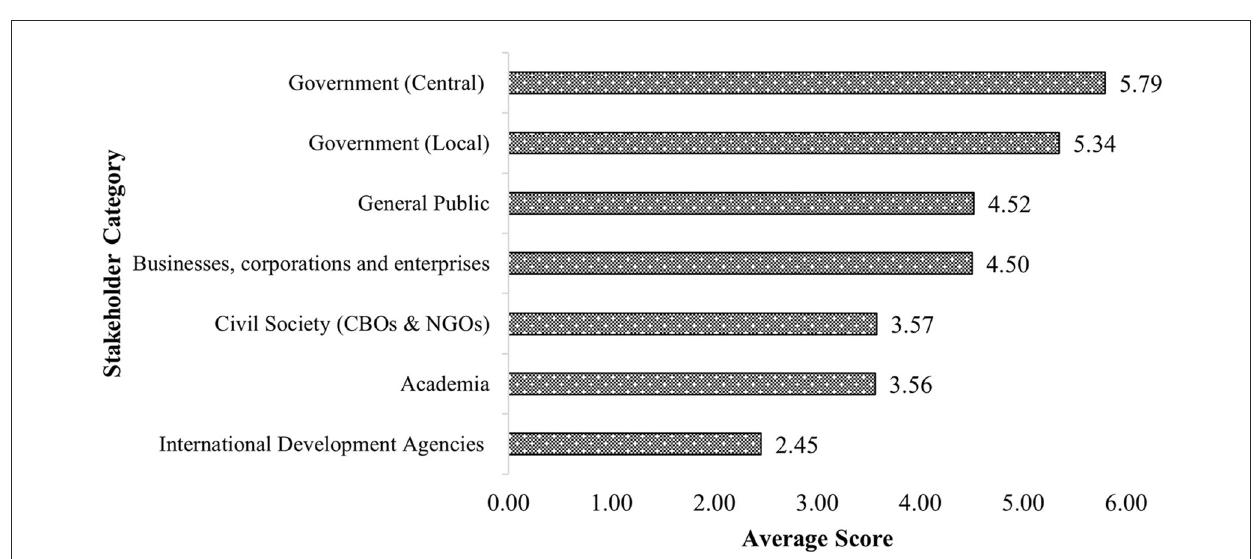
FIGURE8 Respondents’ perception of stakeholder responsibilities in the CE